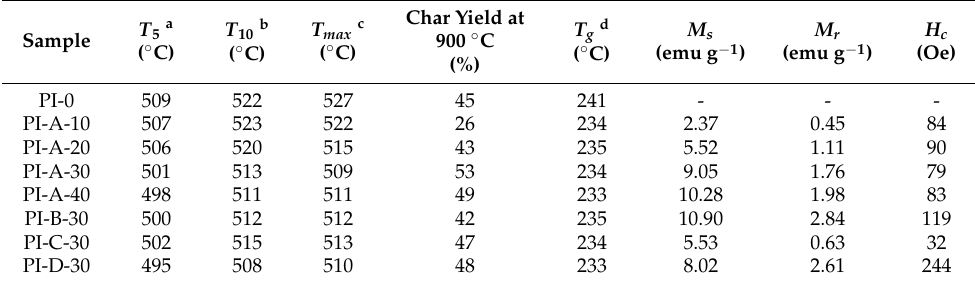
Table 3. The main thermal and magnetic characteristics of the samples.